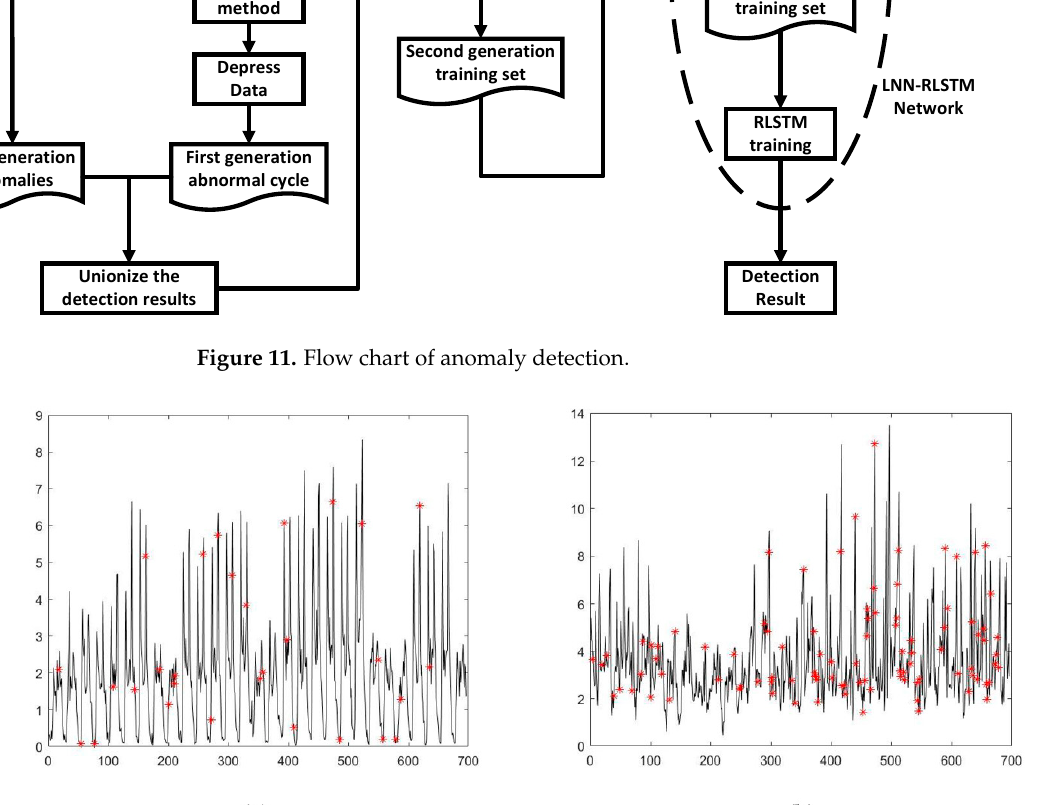
Figure 12. Anomaly detection of three types of KPI data. ( a ) Anomaly detection of average # of users. ( b ) Anomaly detection of average # of activated users. ( c ) Anomaly detection of cell PDCP traf- fic . 8. Evaluation 8.1. Dataset The dataset used in this experiment comes from 67 KPI indicators, corresponding to 58 cells covered by five base stations for a total of 29 days from 28 August 2021 at 00:00 to 25 September at 23:00 of the National University Big Data Contest, and they are manually labeled accordingly. We select three KPIs with different characteristics and they have the same 1 h interval between observations. Table 2 shows the detail information of the da- taset we used.